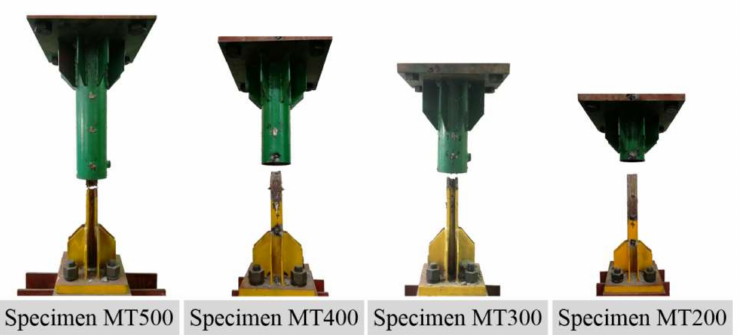
Figure 7. Failure mode of steel profile fracture for Specimens MT500, MT400 and MT300, as well as steel profile pull-out for Specimen